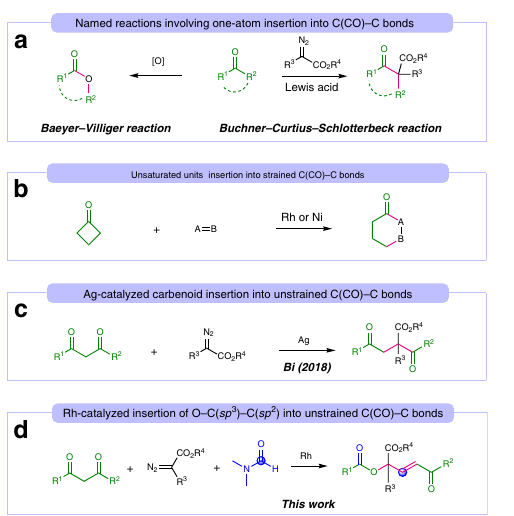
Fig. 1 Functional groups insertion into C(CO) − C bonds. a Named reactions involving one-atom insertion into C(CO) − C bonds. b Unsaturated units insertion into strained C(CO) − C bonds. c Ag-catalyzed carbenoid insertion into unstrained C(CO) − C bonds. d Rh-catalyzed insertion of O-C (sp 3 )-C(Sp 2 ) into unstrained C(CO) − C bonds.